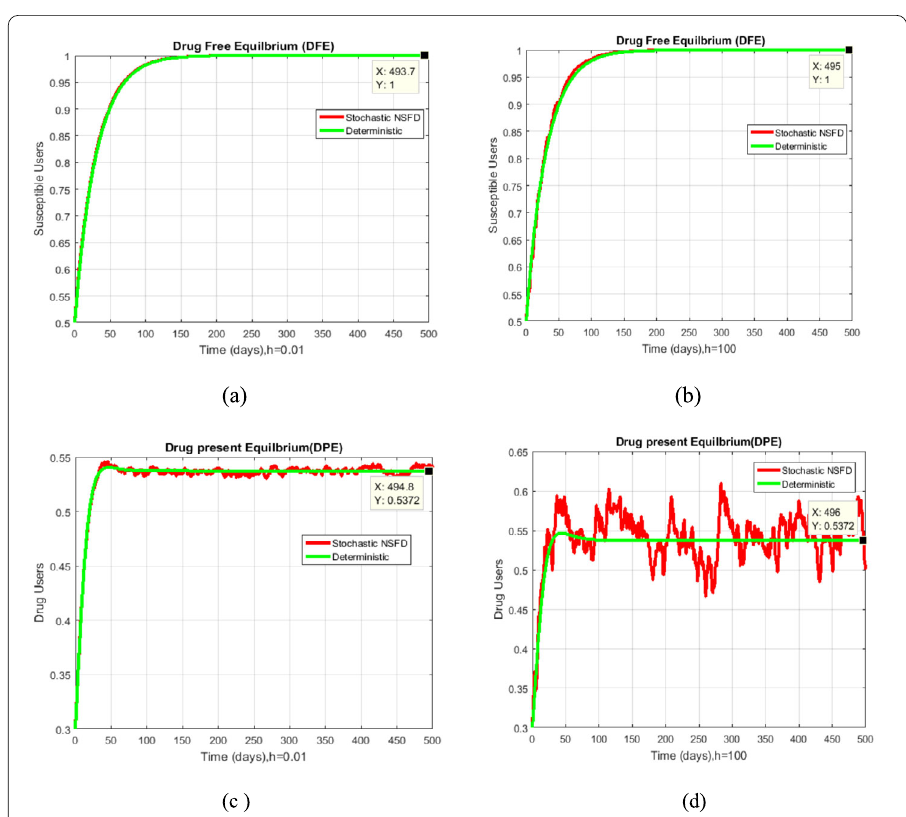
Figure 5 ( a ) In susceptible users’ fraction stochastic-NSFD converges to drug-free equilibrium, while the deterministic solution is the mean of stochastic NSFD solution for h = 0.01. ( b ) In susceptible users’ fraction stochastic-NSFD preserves all dynamical properties for drug-free equilibrium for h = 100. ( c ) In drug users’ fraction stochastic-NSFD converges to drug-present equilibrium, while deterministic solution is the mean of stochastic NSFD solution for h = 0.01. ( d ) In drug users’ fraction stochastic-NSFD preserves all dynamical properties for drug-present equilibrium, while deterministic solution is the mean of stochastic NSFD solution for h =